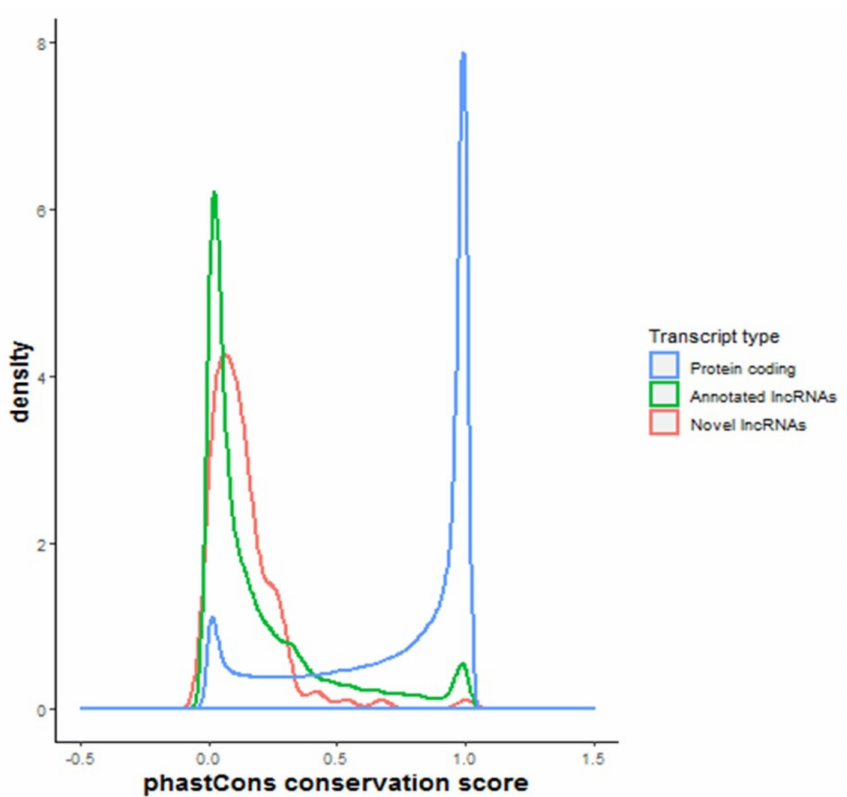
Figure 3. Geometric density plots showing the frequency of phastCons conservation scores for 20 mammalian species averaged base-wise for each exon. Exons from protein-coding transcripts (expressed in this study) are shown in blue, the exons from annotated lncRNAs (expressed in this study) are shown in green and 10 identified novel lncRNAs are shown in red. The phastCons score estimates the probability that a nucleotide is conserved; the closer the score is to 1, the more conserved the